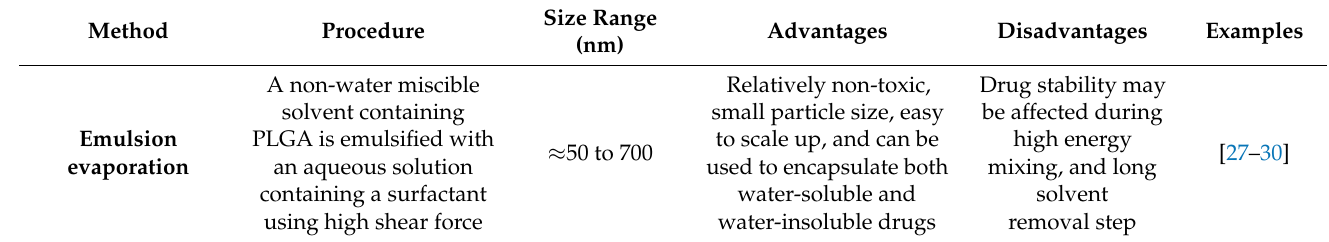
Table 2. Major methods used in the fabrication of PLGA